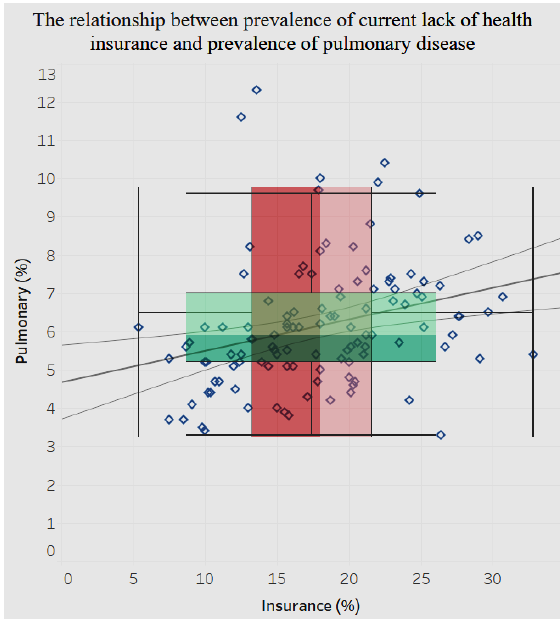
Figure 22. Lack of insurance by pulmonary